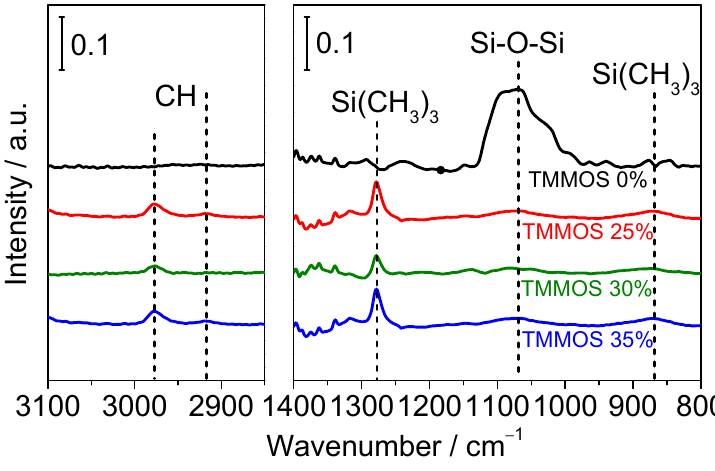
Figure 8. Infrared (IR) spectra (backgrounds were substrated).